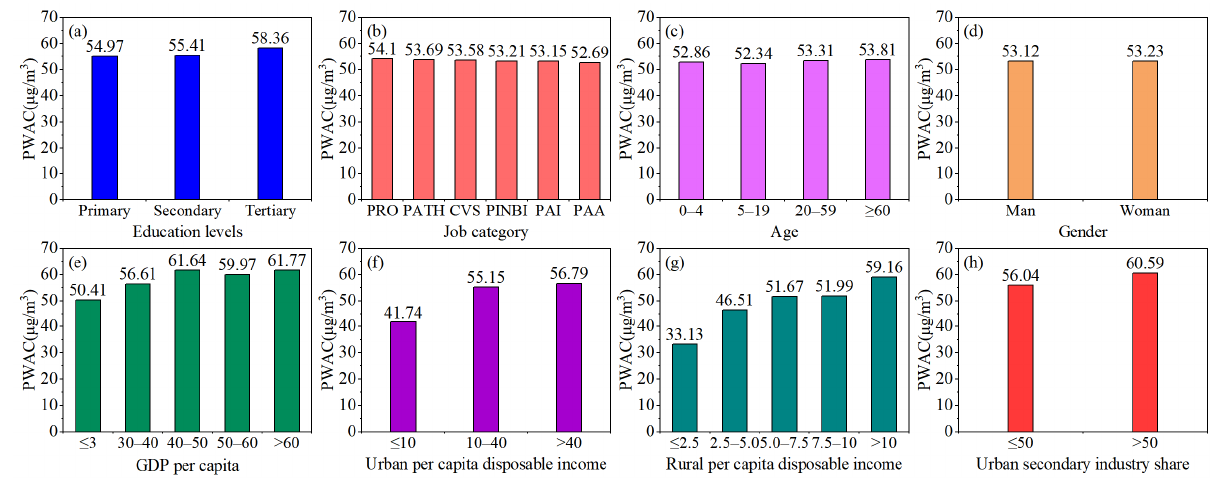
Figure 5. Cumulative annual average population weighted exposures to PM 2.5 concentrations for different population subgroups: ( a ) Education levels, ( b ) Job category, ( c ) Age, ( d ) Gender, ( e ) GDP per capita, ( f ) Urban per capita disposable income, ( g ) Rural per capita disposable income, ( h ) Urban secondary industry share.